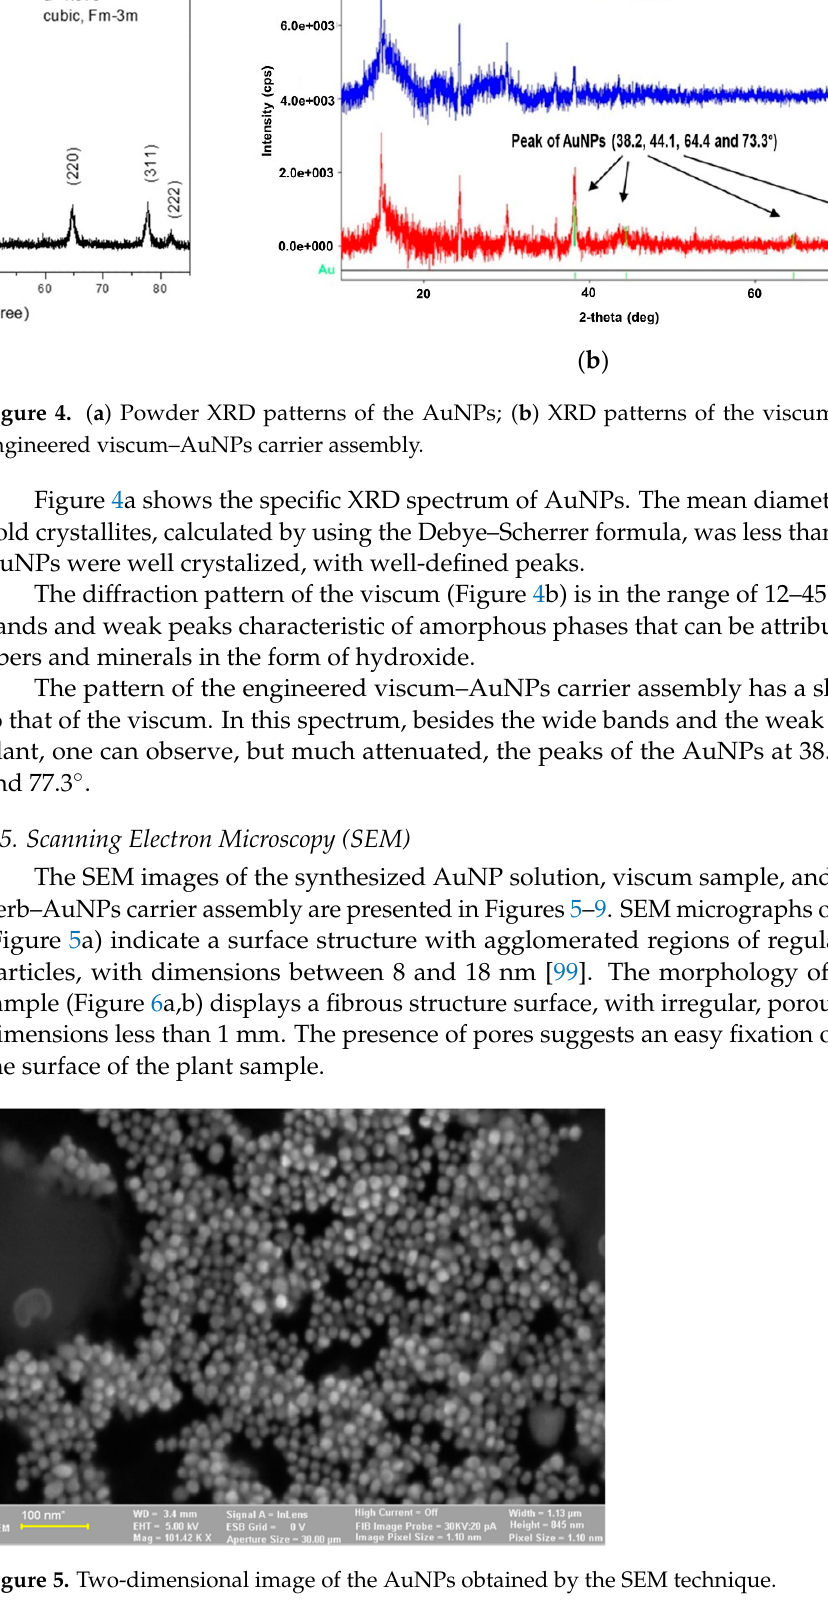
Figure 6. ( a ) Two-dimensional image of the viscum sample obtained by the SEM technique (magni- tude 200 µm). ( b ) Two-dimensional image of the viscum sample obtained by the SEM technique (magnitude 50 µm). The morphology of engineered viscum–AuNPs carrier assembly indicates the presence of AuNPs and agglomerations of AuNPs, fixed on the surface of viscum particles (Figure 7a) as well as loaded into the pores of viscum particles (Figure 7b). Figure 8 shows the live map of viscum and the distribution of the identified ele- ments. Figure 9 shows the live map for the engineered viscum–AuNPs carrier assem- bly and the distribution of the identified elements. The comparative analysis of Figure 8 shows the live map for viscum and engineered viscum–AuNPs carrier assembly (Figure 9) and highlights the presence of differences regarding the proportion of iden- tification elements in the two samples, due to the formation of the viscum–metal car- rier assembly. SEM analysis and live map confirms the obtaining of the engineered viscum–AuNPs carrier assembly [74].